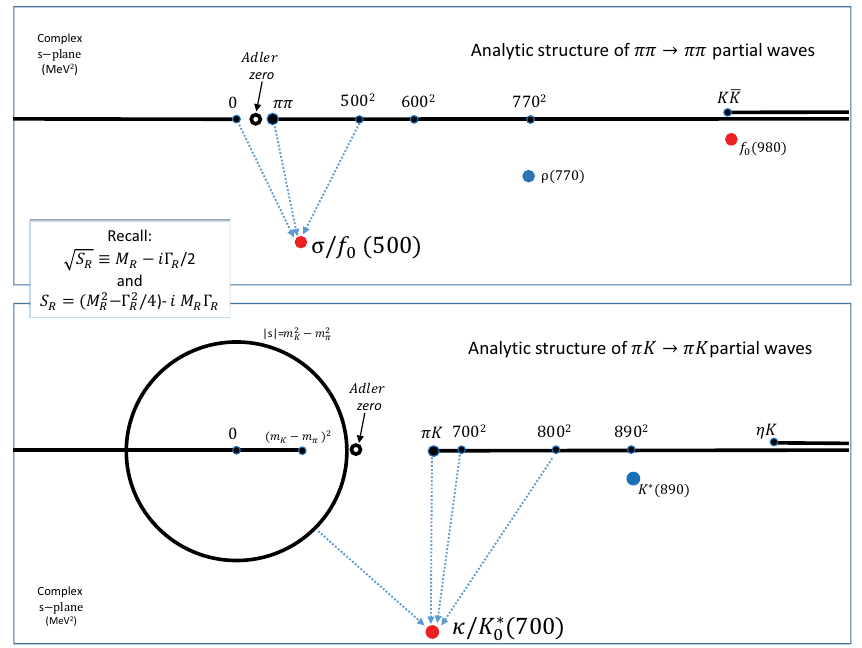
Figure 4. Analytic structure in the s -complex plane of the ππ (top) and π K → π K partial waves (bottom). Figure taken from